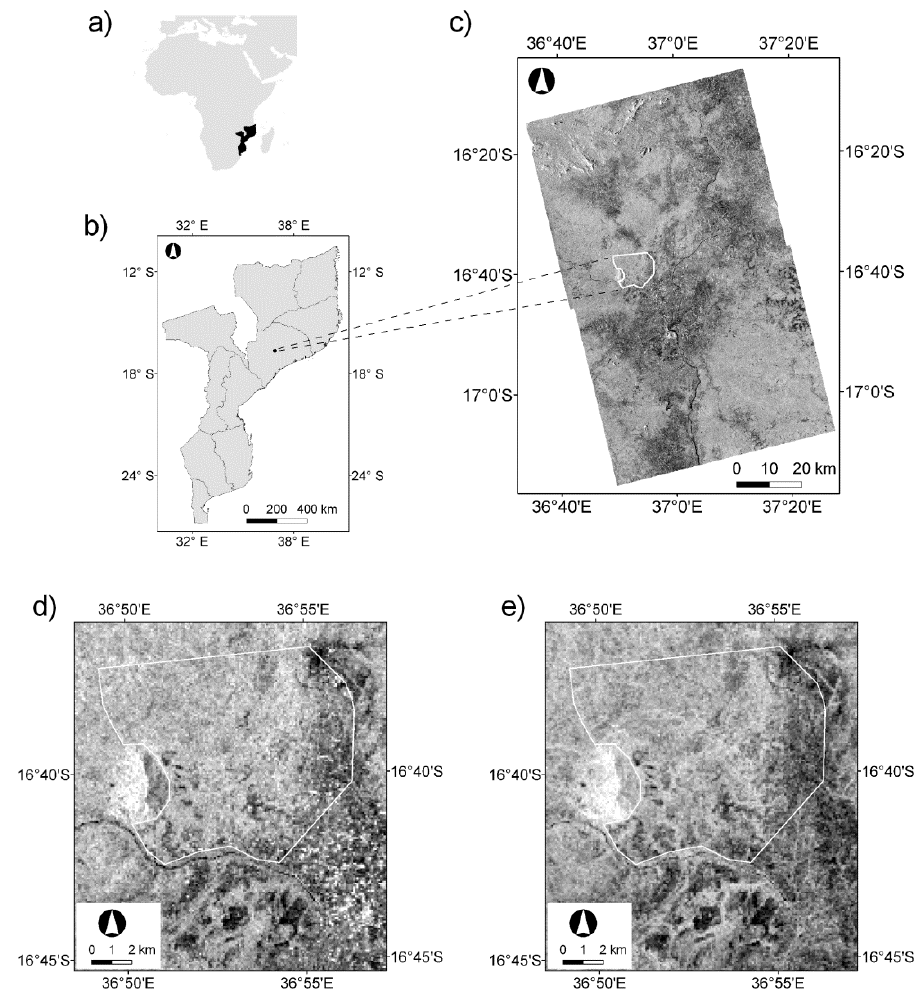
Figure 1. ( a ) Location of Mozambique in Africa; ( b ) Mozambique provinces and location of the study area in the Zambezia province; ( c ) mosaic of the two ALOS PALSAR Fine Beam Dual (FBD) scenes (HH polarization 90 m mosaic) and limits (in white) of the study area. ALOS PALSAR FBD zoom over the ~10,000 ha study area; ( d ) HH polarization; ( e ) HV